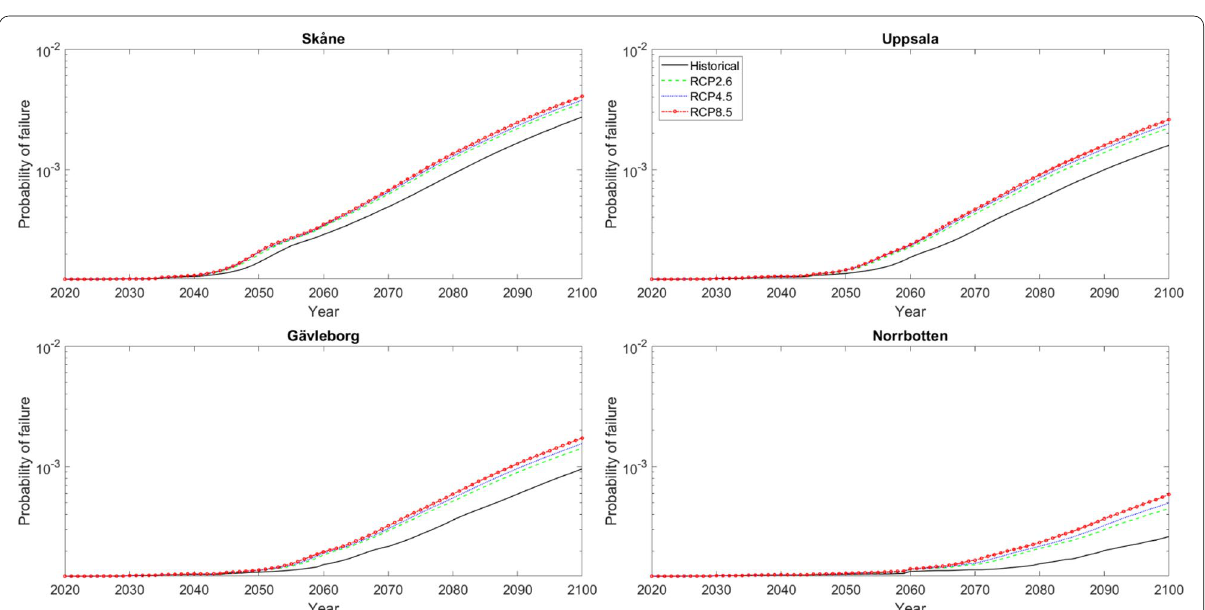
Fig. 8 Probability of failure for the studied beam under the historical (1961 – 1990) and future climatic conditions for Skåne, Uppsala, Gävleborg, and